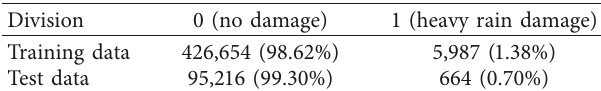
Table 4: Types of training data and test